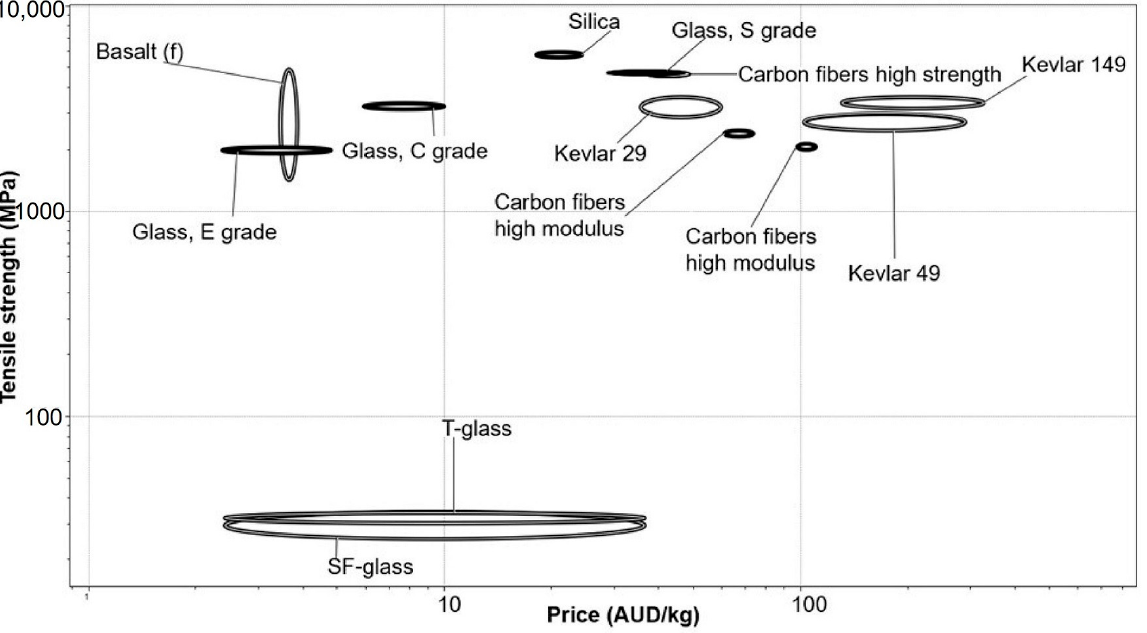
Figure 2. Tensile Strength versus Price (Generated by CES EduPack, 2015).